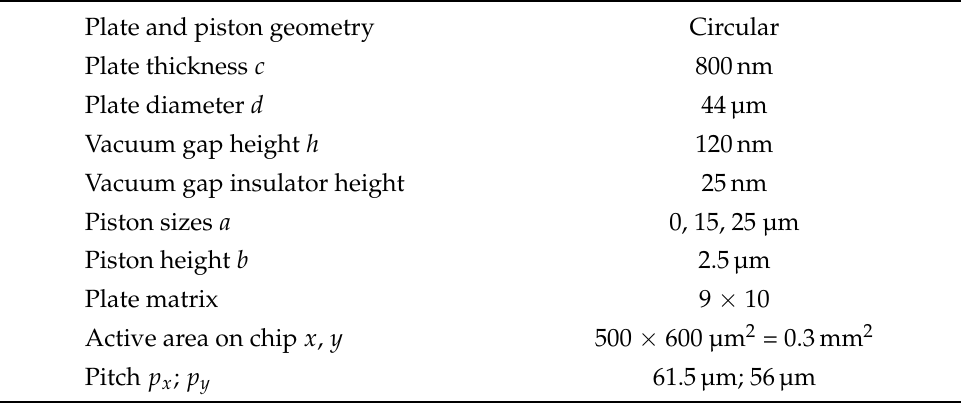
Table 2. Design parameters of CMUT with